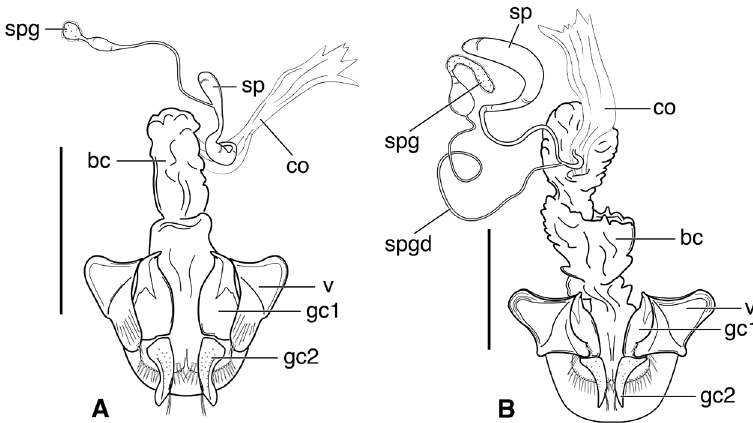
Figure 44. Line drawings of female reproductive tract of Selenophorus opalinus species group, in part, ventral aspect. A S. flavilabris ubancus Ball & Shpeley B S. opalinus LeConte. Legend: bc bursa copulatrix co common oviduct gc1 gonocoxite 1 gc2 gonocoxite 2 sp spermatheca spg spermathecal gland spgd spermathecal gland duct v valvifer. Scale bar 1 mm.